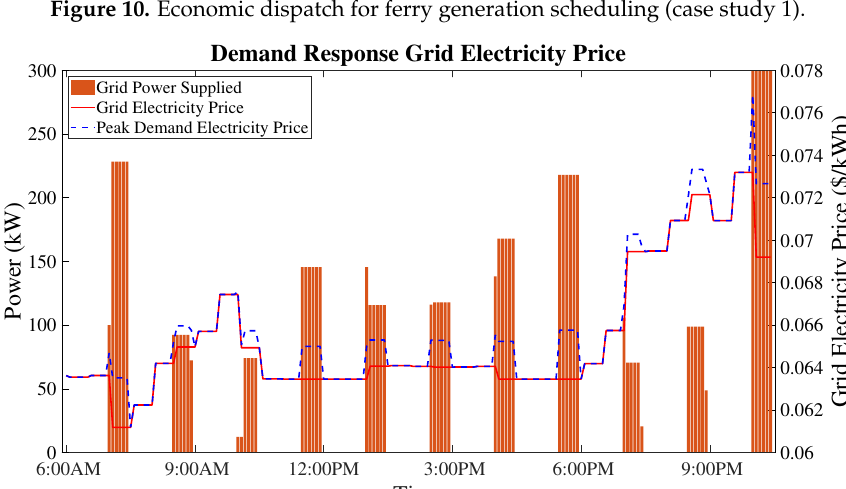
Figure 11. Shore-to-ship (S2S) power demand and peak demand response electricity price (case study